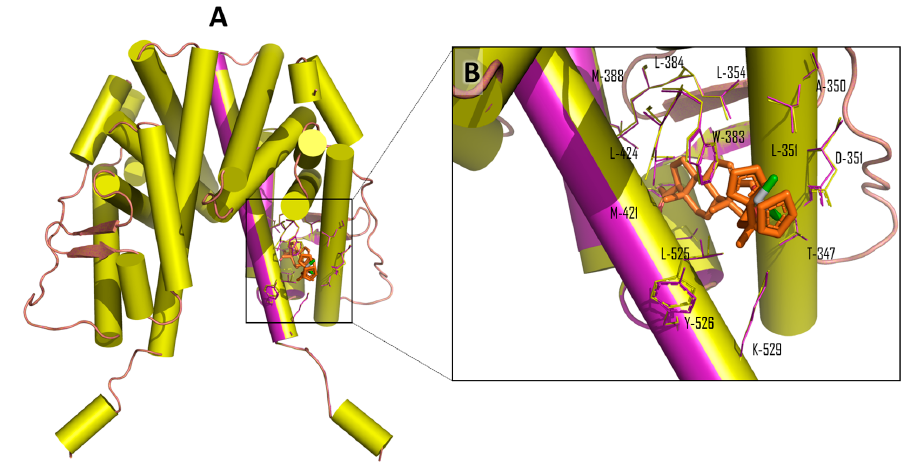
Figure 6. Superposition of ER α -LBD before docking with Ti-pregnenolone (green) and after docking with Ti-pregnenolone complex (violet) demonstrating the repositioning and opening of the binding site, ( A ) full structure ( B ) ligand-binding site.